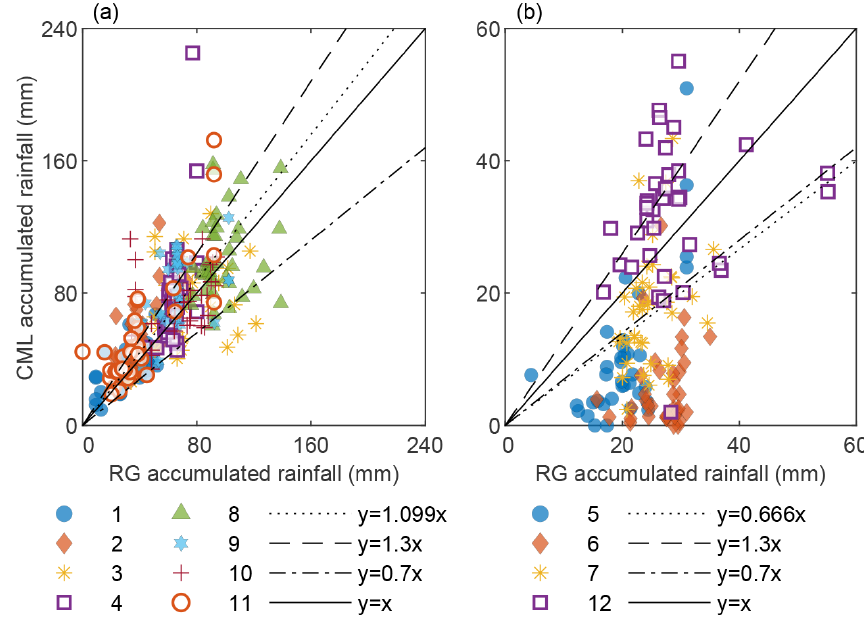
Figure 4. Accumulated rainfall during (a) high-rain-rate events and (b) low-rain-rate events: CMLs against nearby RGs. The best fit of data, the ± 30% bounds, and the 45 ◦ line are shown as well. In the legend, numbers refer to the storm events, and markers are the selected CMLs.